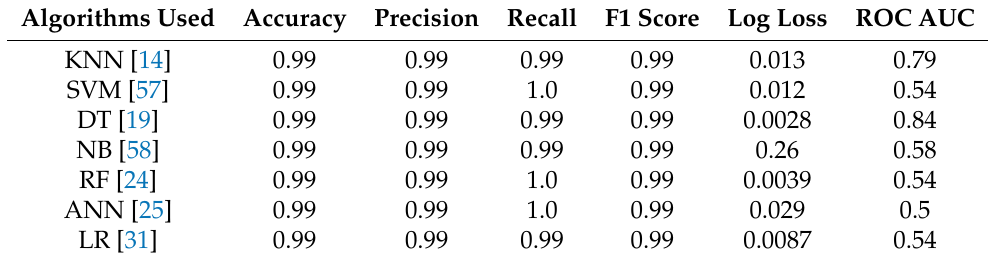
Table 28. Service Scan results.